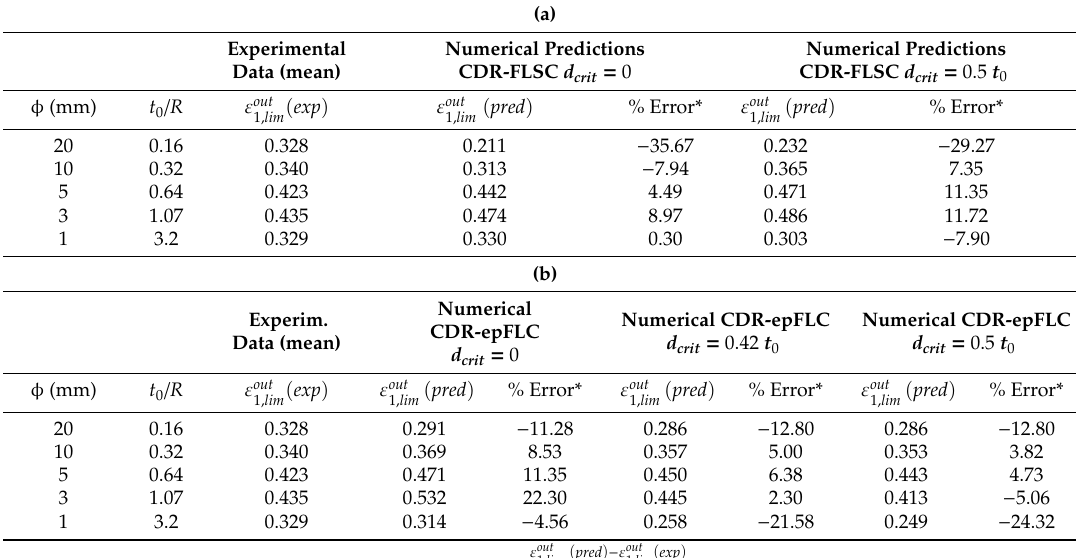
Figure 15. Experimental and numerical necking major strain (%) versus the t 0 / R ratio using ( a ) CDR-FLSC and ( b ) CDR-epFLC models for cylindrical punches. Table 3. Comparison of experimental and numerical results of limit major strain at the outer surface using ( a ) CDR-FLSC and ( b ) CDR-epFLC models for di ff erent values of critical distances ( d crit )